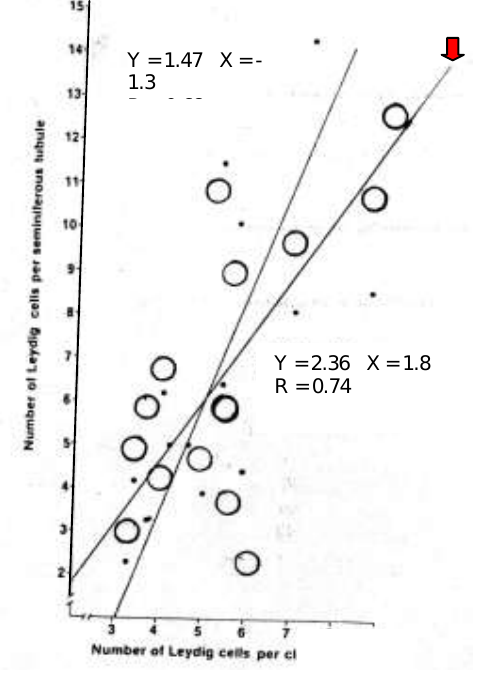
Fig. (3) Correlation of each Gossypol and control groups in correlation between Leydig cells per cluster and Leydig cells per Semineferous tubule (P <